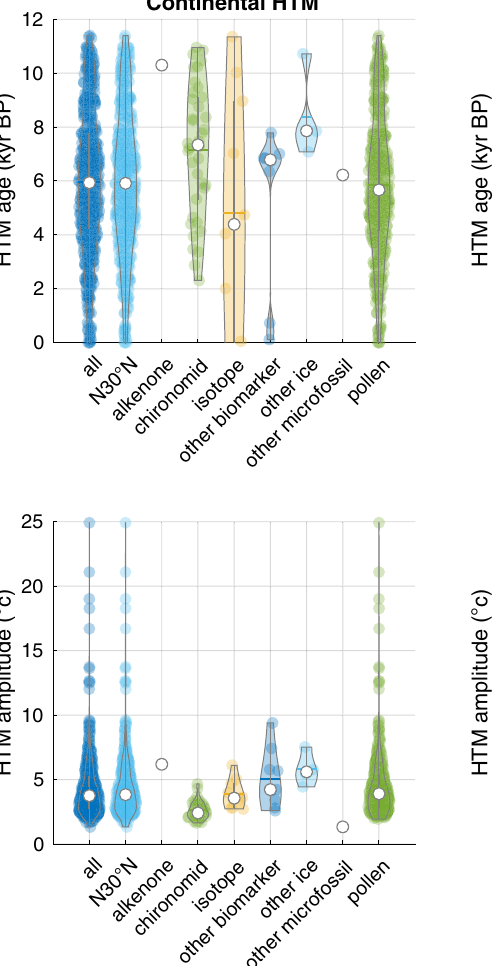
The category named “ all ” includes every records while the ” N30°N ” category includes all records north of 30°N. The mean (white dot) and median (colored horizontal bar) are displayed for each